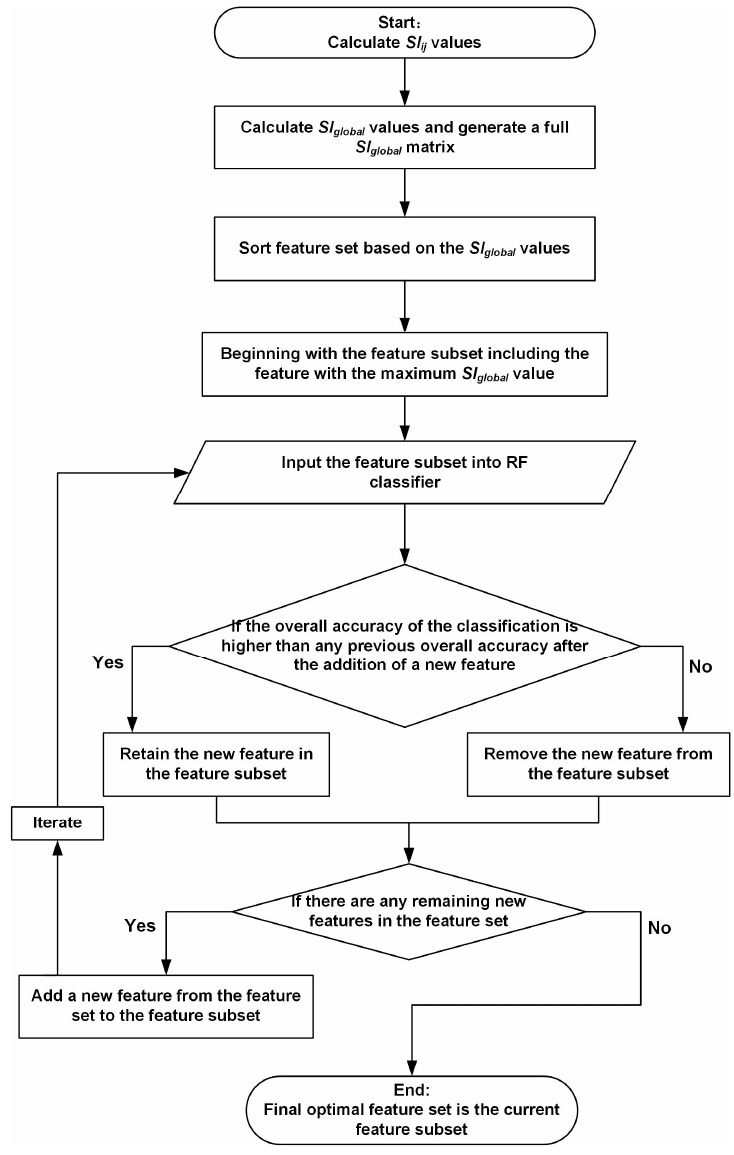
Figure 3. The workflow of the automatic spectro-temporal feature selection (ASTFS) method for selecting the optimal features for certain crop type. RF, Random Forest.